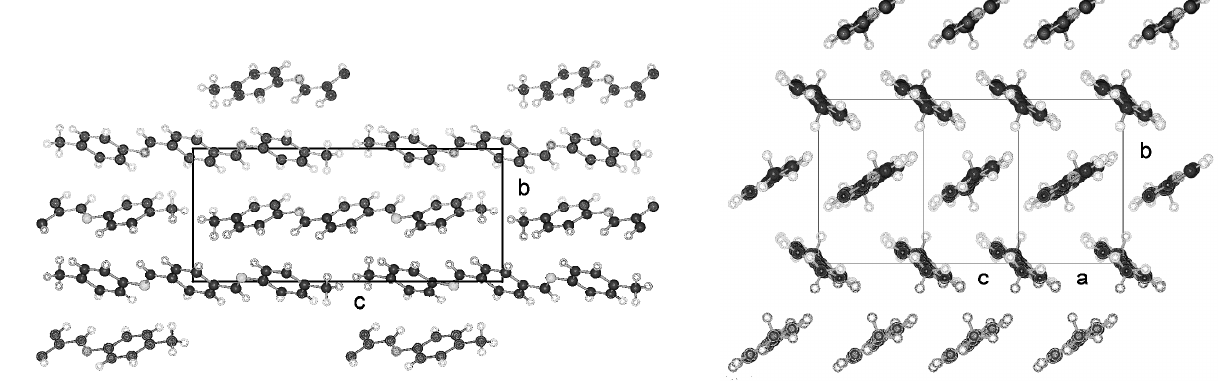
Figure 25. Representation of the packing arrangement of TBAA-1, space group P2 two projections, on the b,c-plane and down the molecular axes to demonstrate the string-like arrangements of neighboring molecules. Note the different orientation of the molecules as compared to TBAA-0 (Figure